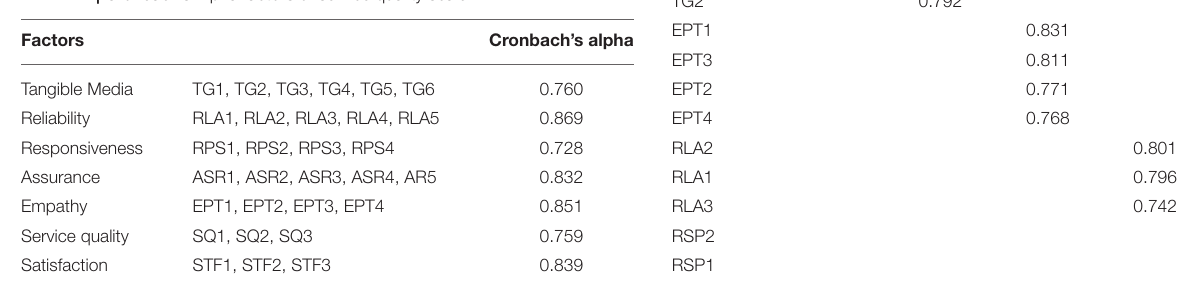
TABLE 2 | Cronbach’s Alpha factors of service quality scale